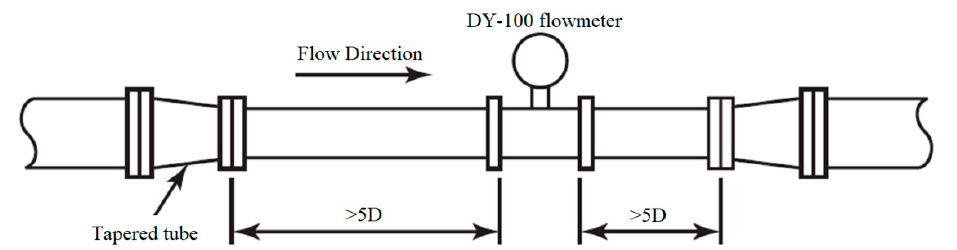
Figure 16. Installation of the DY-100 digital vortex flowmeter.